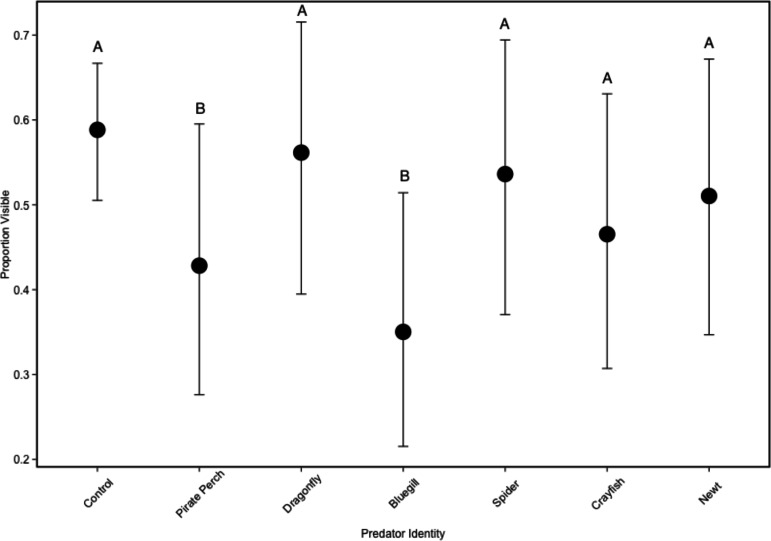
Tadpole visibility patterns with different predators.The model-generated mean visibility of Lithobates sphenocephalus tadpoles in the non-lethal predator treatments with 95% confidence intervals (\documentclass[12pt]{minimal}
\usepackage{amsmath}
\usepackage{wasysym}
\usepackage{amsfonts}
\usepackage{amssymb}
\usepackage{amsbsy}
\usepackage{upgreek}
\usepackage{mathrsfs}
\setlength{\oddsidemargin}{-69pt}
\begin{document}
}{}${\chi }_{5}^{2}=127.43$\end{document}χ52=127.43, P < 0.001). Treatments that share the same letter are not significantly different from the control, as determined by false discovery rate corrected post hoc analysis.